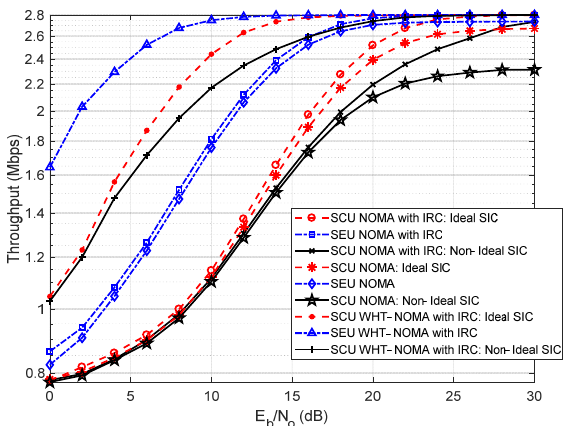
Figure 19. Throughput performance with IRC using QPSK modulation; NOMA vs. WHT–NOMA, power allocation: SCU = 0.2 and SEU = 0.8.